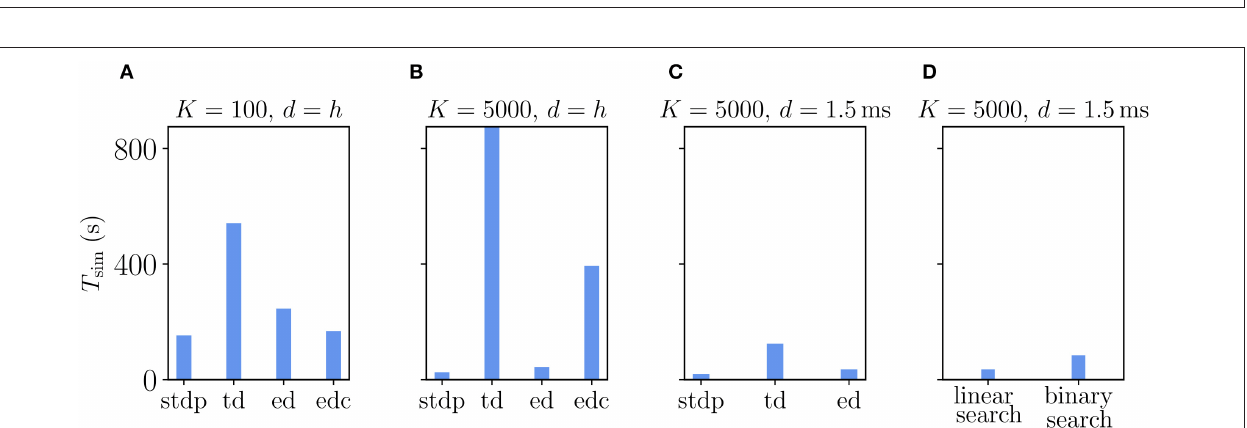
FIGURE 8 | Reproduction of results with Urbanczik-Senn rule. (A) Setup of a simple learning task using the Urbanczik-Senn plasticity rule. The somatic conductances g I and g E of a two-compartment neuron are modulated such that they induce a teaching signal with sinusoidal shape. The dendrite receives a repeating spike pattern as an input via plastic synapses (green arrows). (B) The synapses adapt their weights so that the somatic membrane potential U (blue) and the dendritic prediction V i (green) follow the matching potential U M (red) after learning. (C) Excitatory ( g E ) and inhibitory ( g I ) somatic conductances that produce the teaching signal. (A,B) correspond to Figure 1 of Urbanczik and Senn (2014). (D) Temporal evolution of the synaptic weights during learning. For the sake of better overview, only a subset of weights is shown (gray) with three randomly chosen time traces highlighted in blue. Synapses in NEST fulfill Dale’s principle which means that a weight update cannot convert an excitatory into an inhibitory synapse and vice versa giving rise to the rectification at zero.